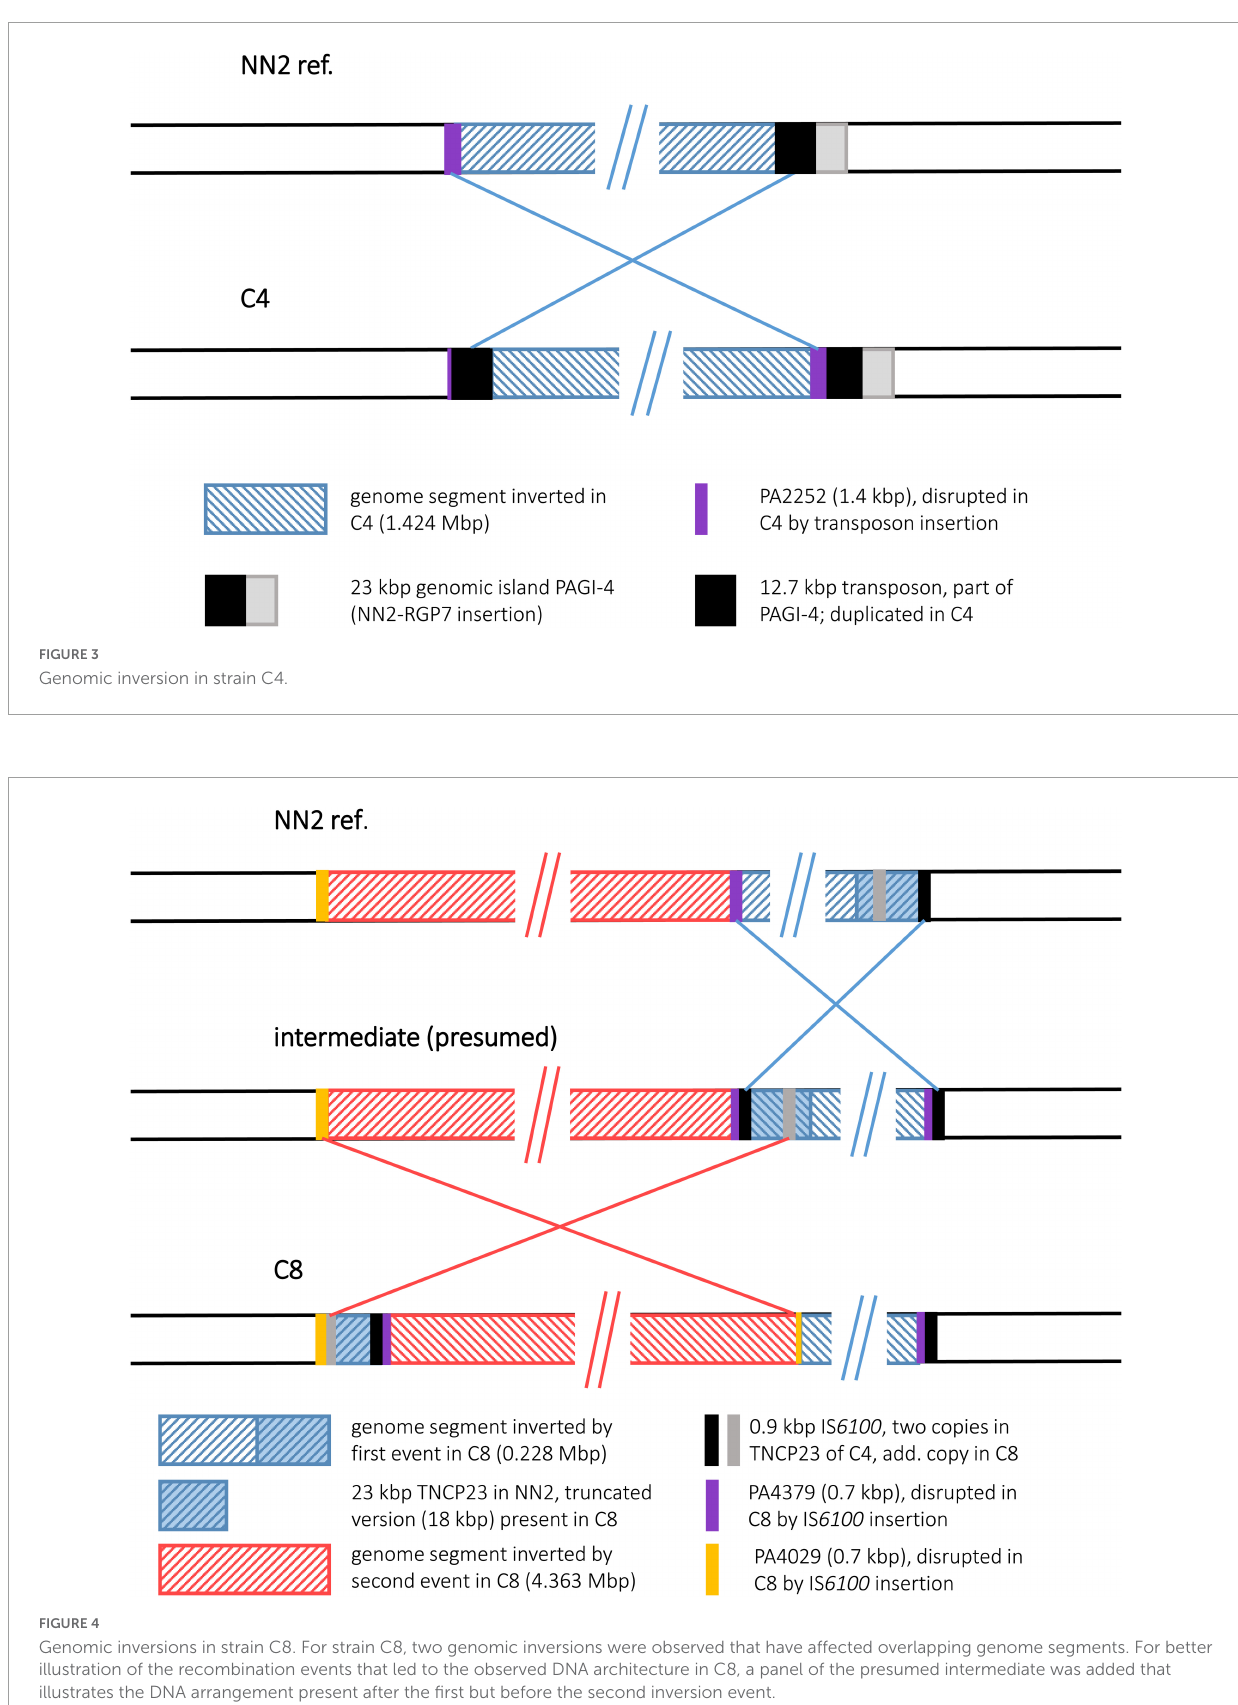
FIGURE4 Genomic inversions in strain C8. For strain C8, two genomic inversions were observed that have affected overlapping genome segments. For better illustration of the recombination events that led to the observed DNA architecture in C8, a panel of the presumed intermediate was added that illustrates the DNA arrangement present after the first but before the second inversion